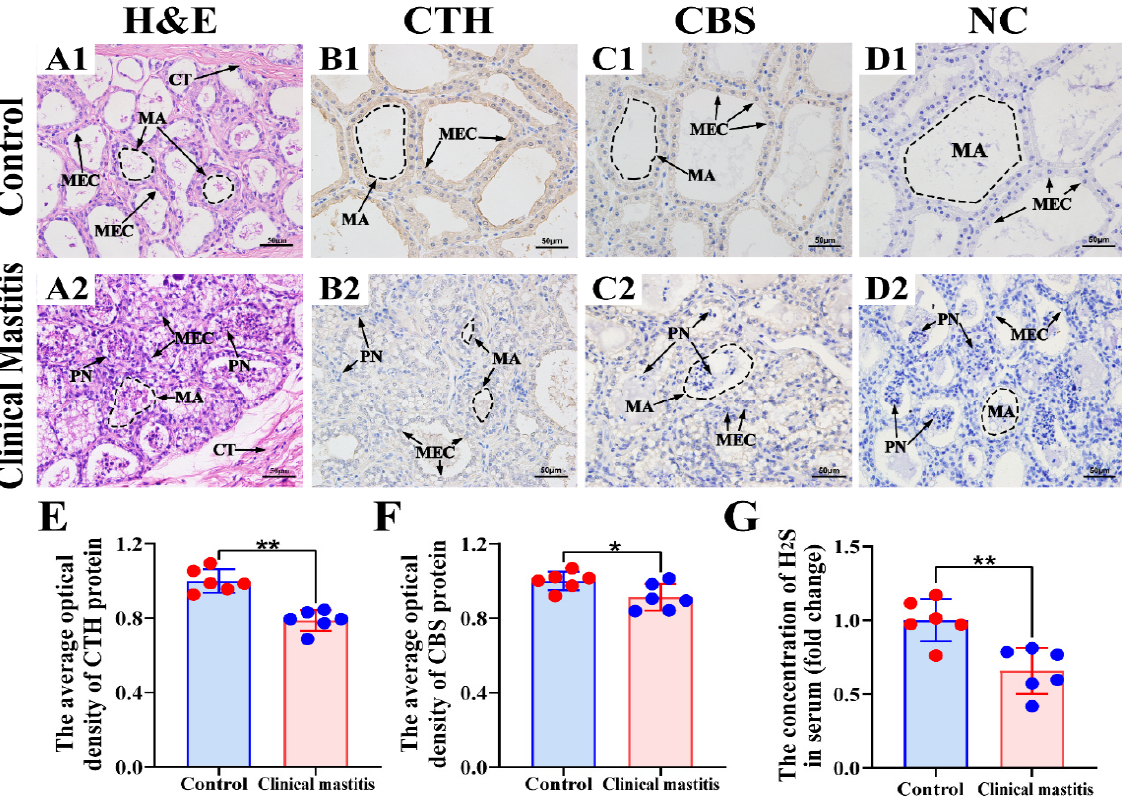
Figure 3. Location analysis of CBS and CTH proteins and measurement of endogenous H 2 S in the mammary glands. ( A ) Pathological variation of the mammary glands of the C ( A1 ) and CM ( A2 ) groups (400×). ( B , C ) Intracellular location analysis of CBS and CTH proteins in the mammary glands of the C ( B1,C1 ) and CM ( B2,C2 ) groups (400×). ( D ) Negative control of the mammary glands of the C ( D1 ) and CM ( D2 ) groups. ( E , F ) The gray value of positive expression of CTH and CBS